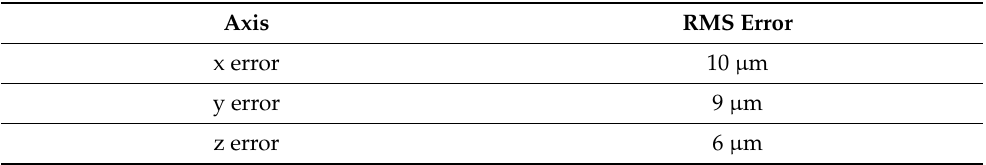
Figure 11. Simulation results of the 3D trajectory (reference and actual) using the PID controller. Table 3. RMS error following the 3D